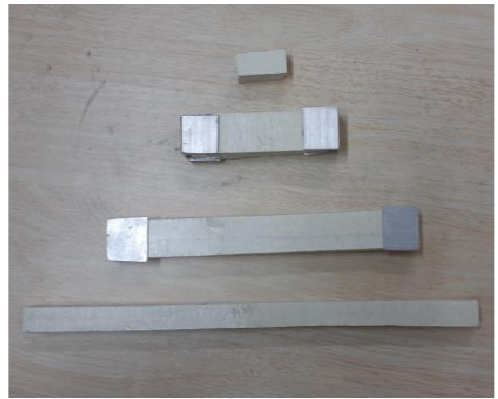
Figure 1. GFRP coupons.